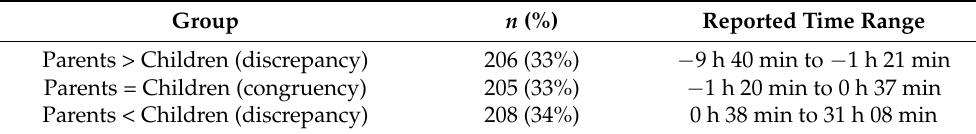
Table 2. Frequency and characteristics of the groups formed based on the difference reported by parents and children regarding the time per week children spent on electronic media (EM). Group n (%) Reported Time Range Parents > Children